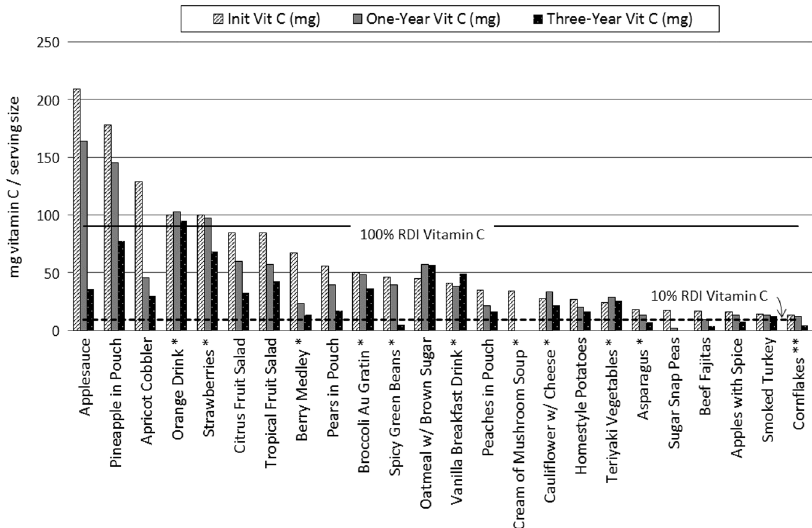
Fig. 2 Vitamin C concentrations in space foods over 3 years of 21 °C storage generally declined from the initial concentration. The rate of decline was most dependent upon the primary food matrix and formulation. Note: Increases in content from the initial concentration in forti fi ed products is likely due to encapsulation, which can impede complete chemical detection until the encapsulation itself degrades over